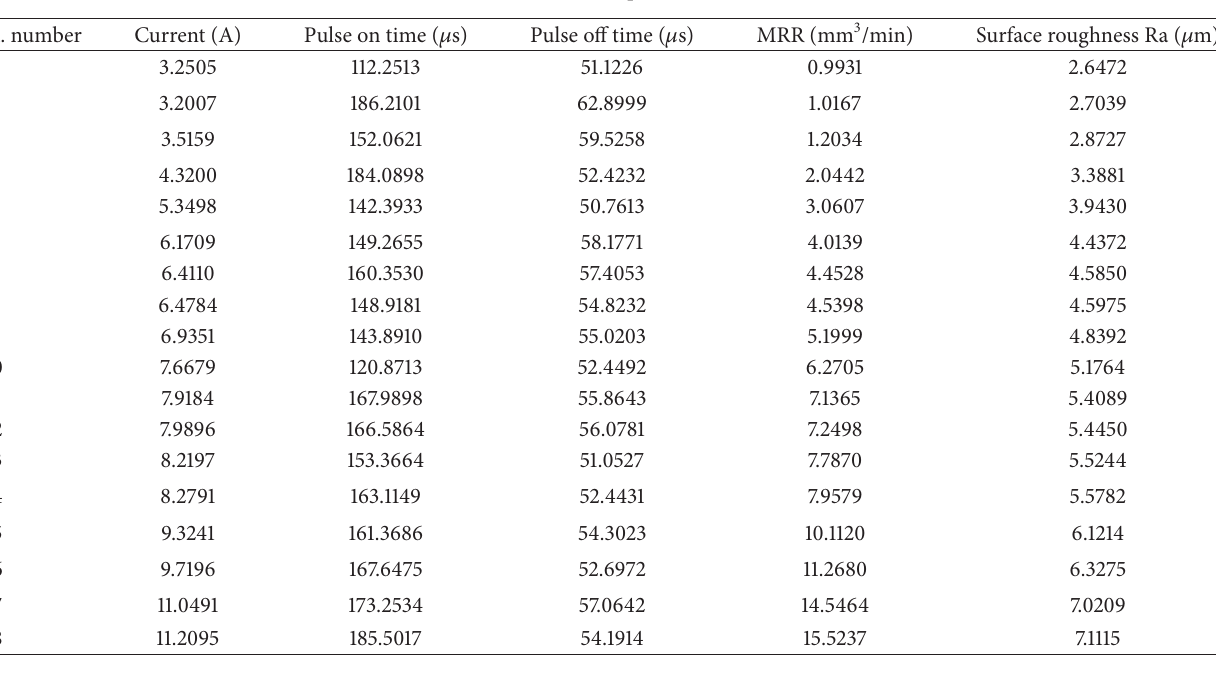
Table 4: Pareto optimal data.